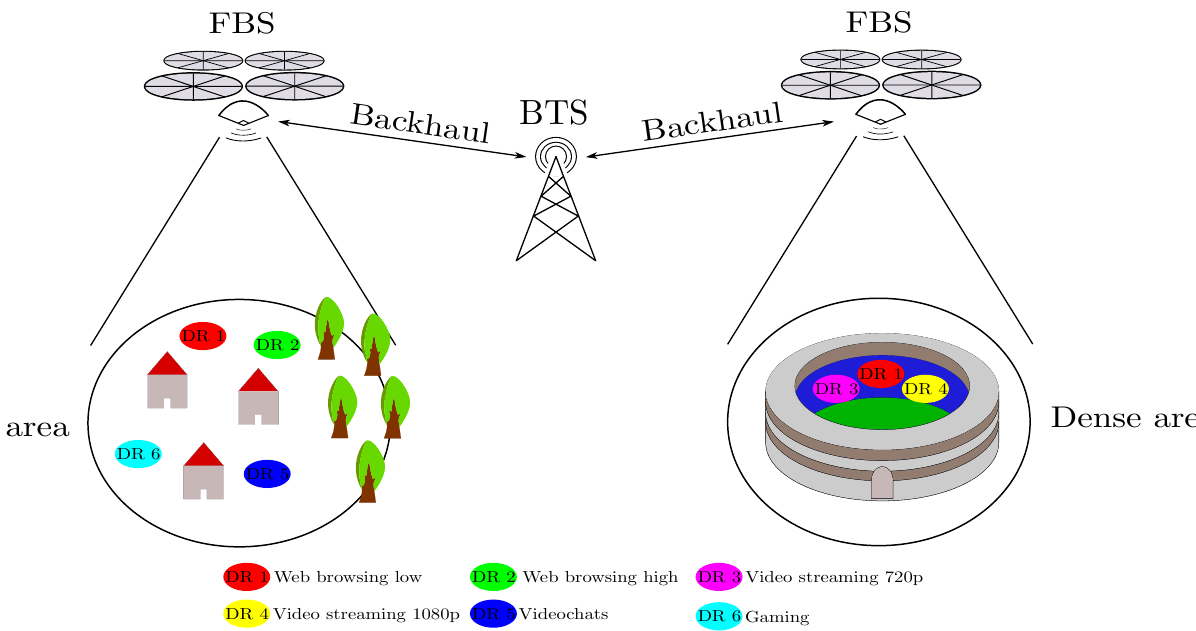
Figure 1. Use-cases with FBSs assisting current infrastructure to extend the coverage in the